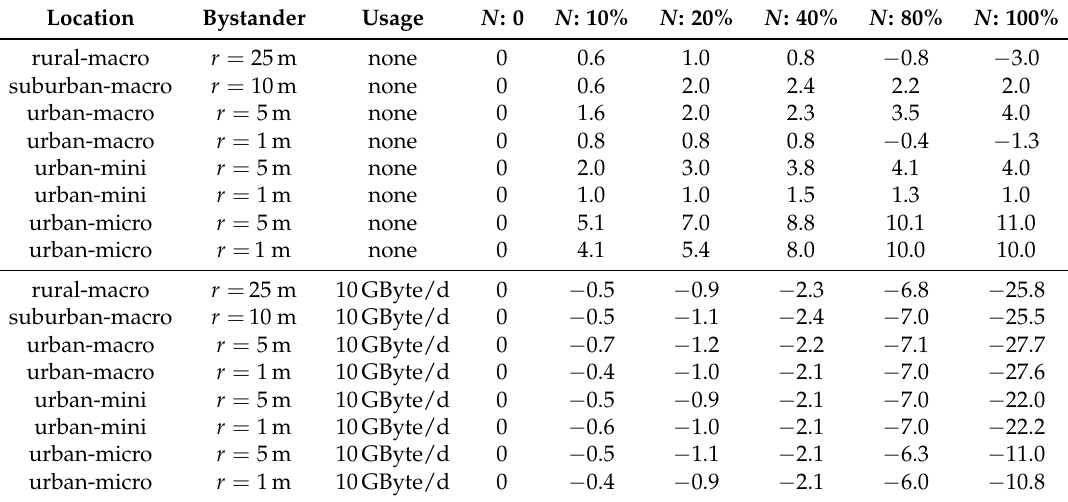
Table 2. Relative effect (in dB) of increased indoor coverage (increasing N ) without cell edge reduction for non-users and heavy users in different environments and bystander conditions. Shown are the 95th percentiles relative to the case for N = 0 in each row.